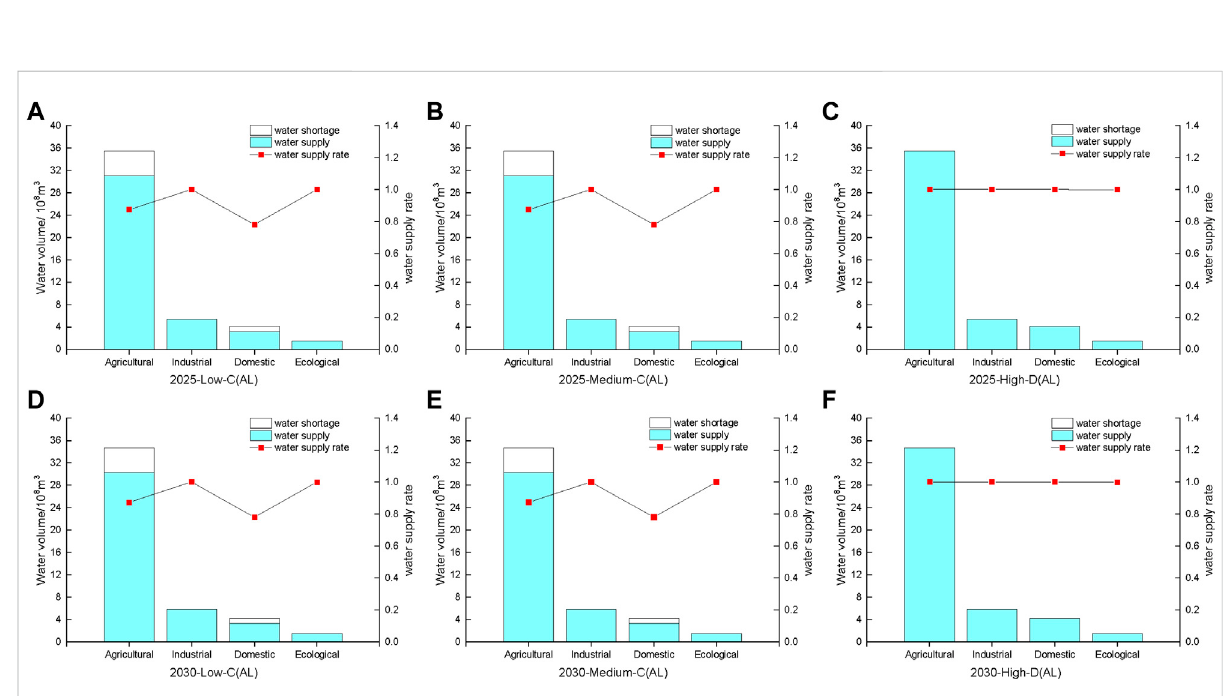
FIGURE 10 Distribution of water resources for six suitable scenarios in Aishan-Luokou section [ (A – F) represent 6 selected scenarios respectively].